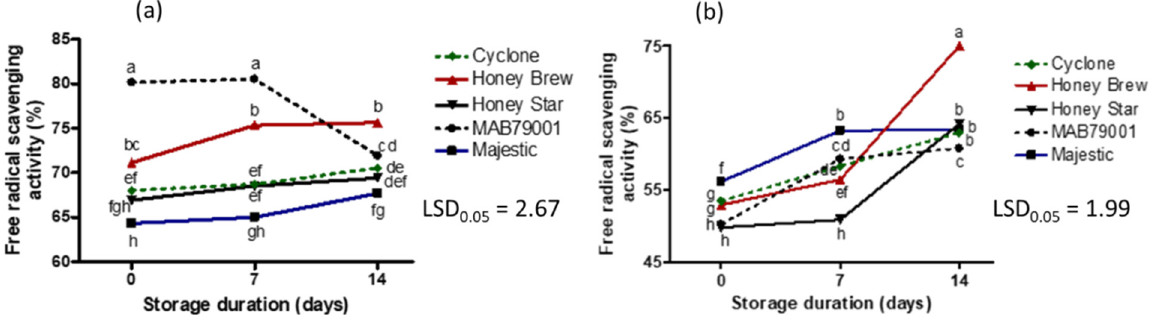
Figure 9. Interaction effect of sweet melon cultivars and storage duration on free radical scavenging activity of 50% methanol ( a ) and water ( b ) extracts. Points on lines with different letters in each graph are significantly different at p ≤ 0.05 (Fisher’s protected LSD test, n = 3).